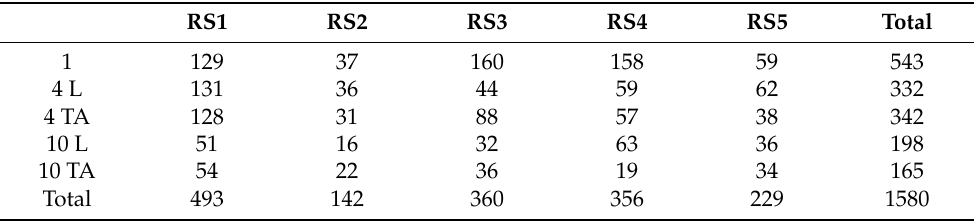
Table 2. Number of overtaking maneuvers registered at each road section considering each configu- ration of the group of cyclists.